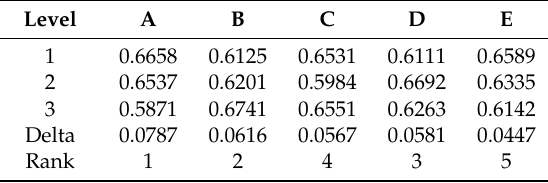
Table 12. Response table for the GRG.